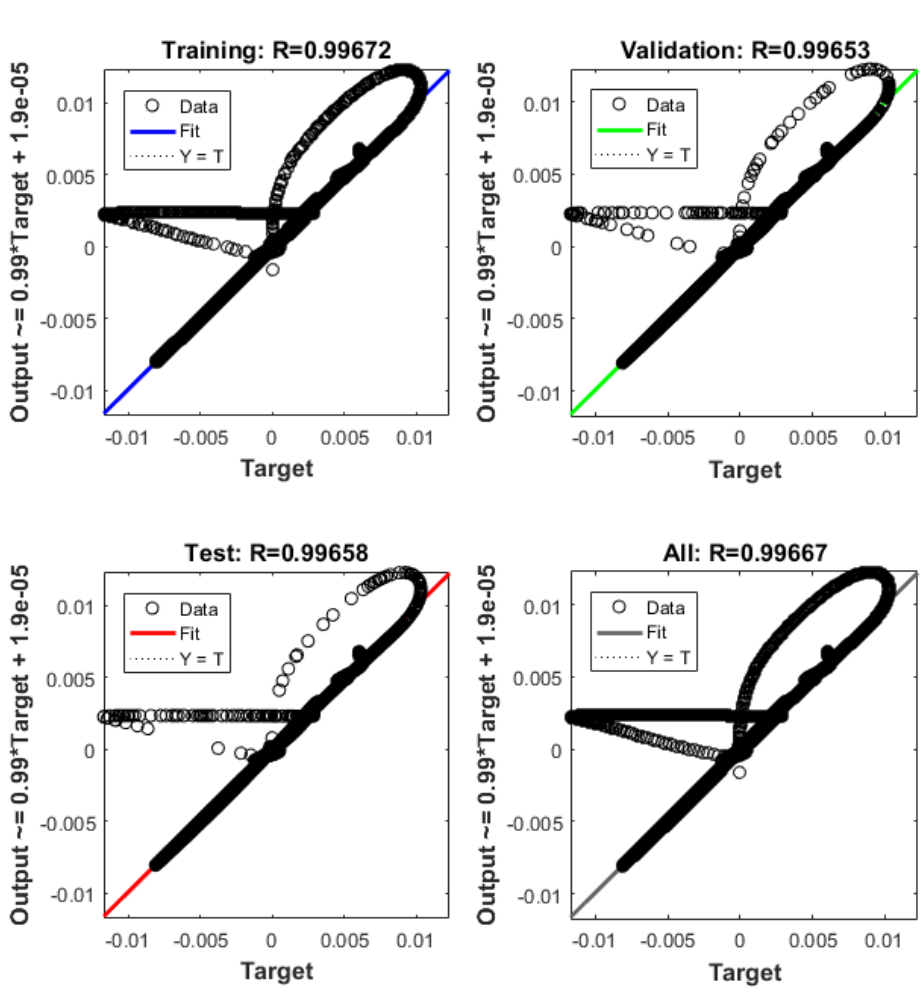
Figure 22. ANN regression plot, equilibrium at x = 0.005 m.